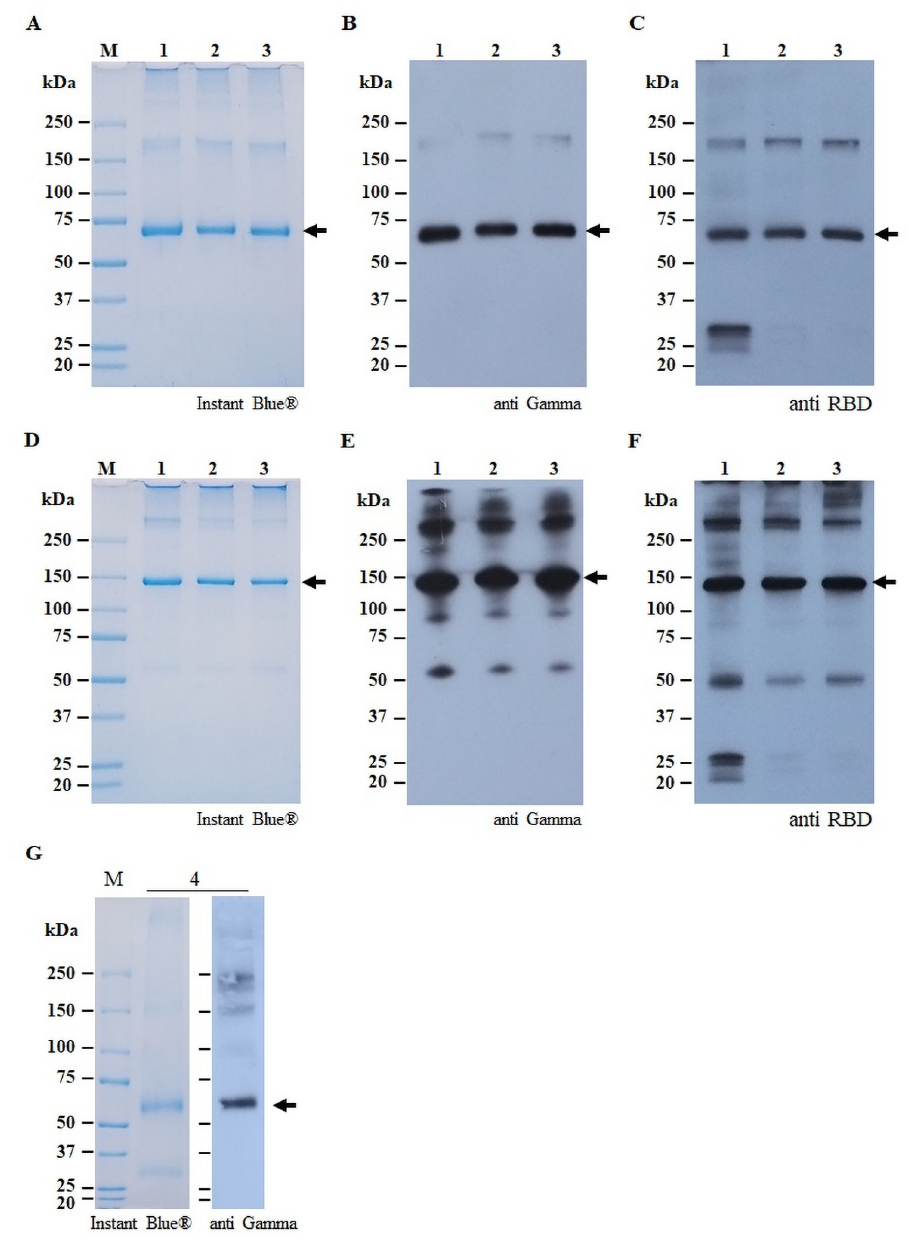
Fig 3. SDS-PAGE and western blot analysis of purified plant-produced SARS-CoV-2 RBD-Fc, variants, and Fc. Purified plant-produced SARS-CoV-2 RBD-Fc, Alpha RBD-Fc, and Beta RBD-Fc variants were evaluated by SDS-PAGE and western blot under reducing condition (A, B, and C) and non-reducing condition (D, E, and F). In addition, purified plant-produced Fc was assessed by SDS-PAGE and western blot under nonreducing condition (G). The proteins were separated by 4–15% SDS PAGE and stained with InstantBlue 1 (A and D). For western blot, the proteins were transferred onto nitrocellulose membrane and probed with HRP-conjugated goat anti-human IgG (B and E) or rabbit anti-SARS-CoV-2 spike protein (RBD) mAb (C and F). Lane 1: purified plant-produced SARS-CoV-2 RBD-Fc; Lane 2: purified plant-produced Beta RBD-Fc protein; Lane 3: purified plant-produced Alpha RBD-Fc protein; Lane 4: purified plant-produced Fc protein. The arrow indicated the expected